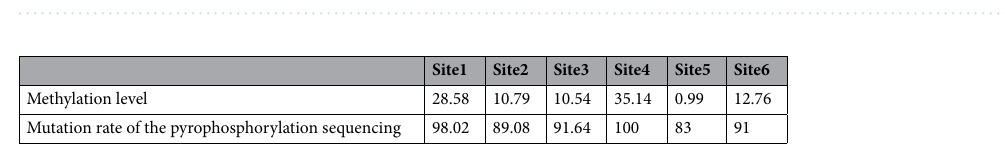
Figure 9. Comparison of mRNA expression levels among the 10 DEGs obtained using qRT-PCR validation and RNA-seq. Log 2 Fold Change are expressed as the ratio of gene expression after normalization to Cytb.